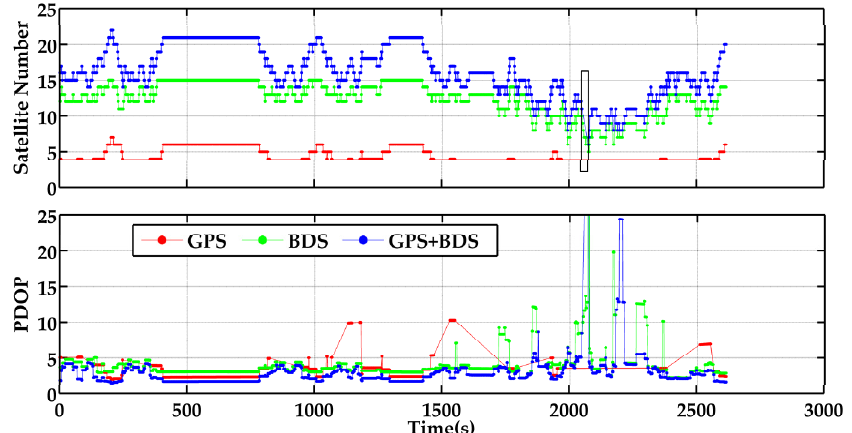
Figure 3. Satellite number and PDOP of GPS-only, BDS-only, and G + B (the start time is 195,453 s (GPS time)); the black rectangle represents the GNSS outage period under G + B mode.